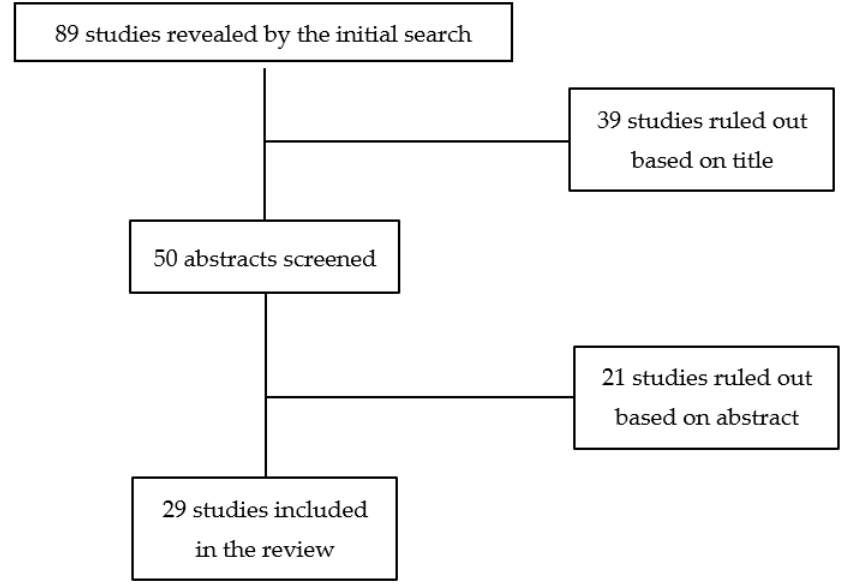
Figure 1 . Flow chart of the included studies